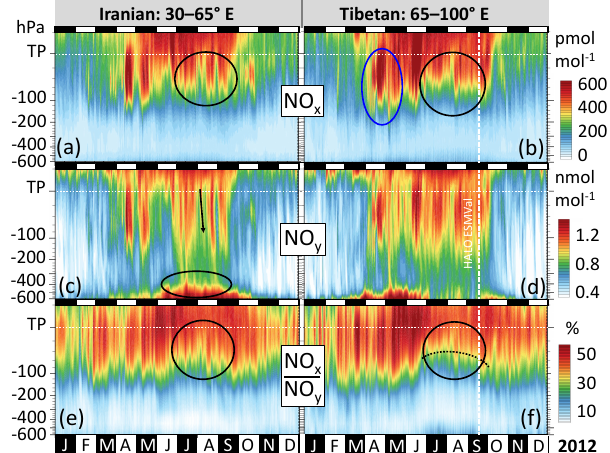
Figure 6. As in Fig. 5, but focusing on reactive nitrogen. Exam- ples of individual profiles from panels (c) and (d) are given in the Supplement.